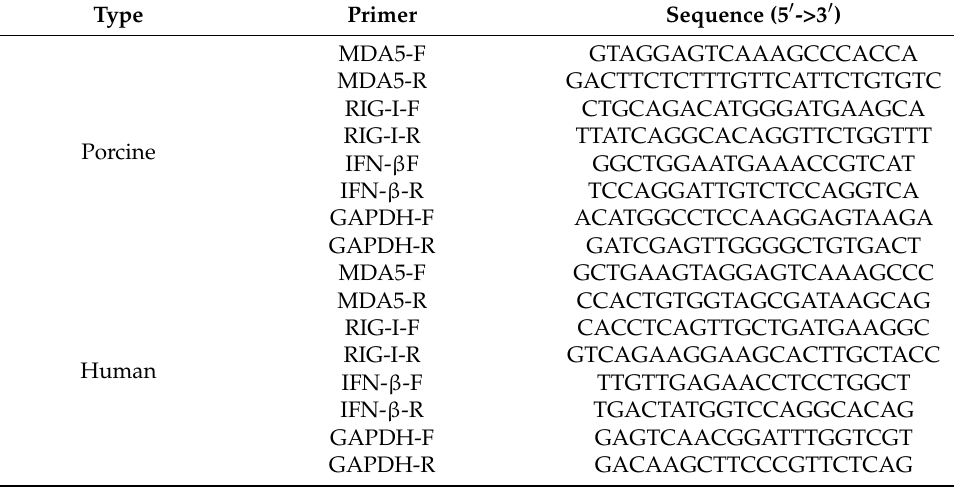
Table 1. The real-time RT-PCR primers for target gene